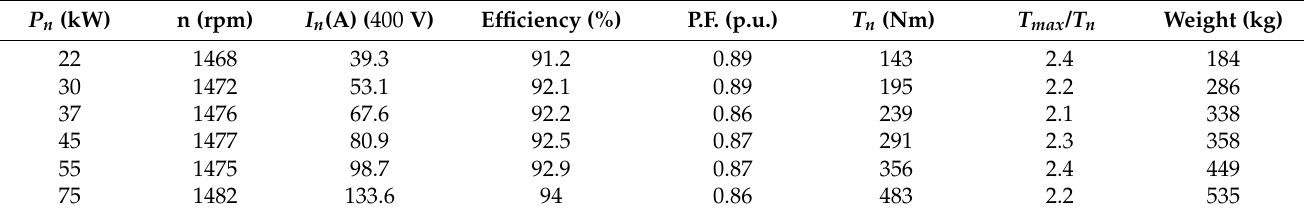
Table 3. Possible AC motors for optimal selection.